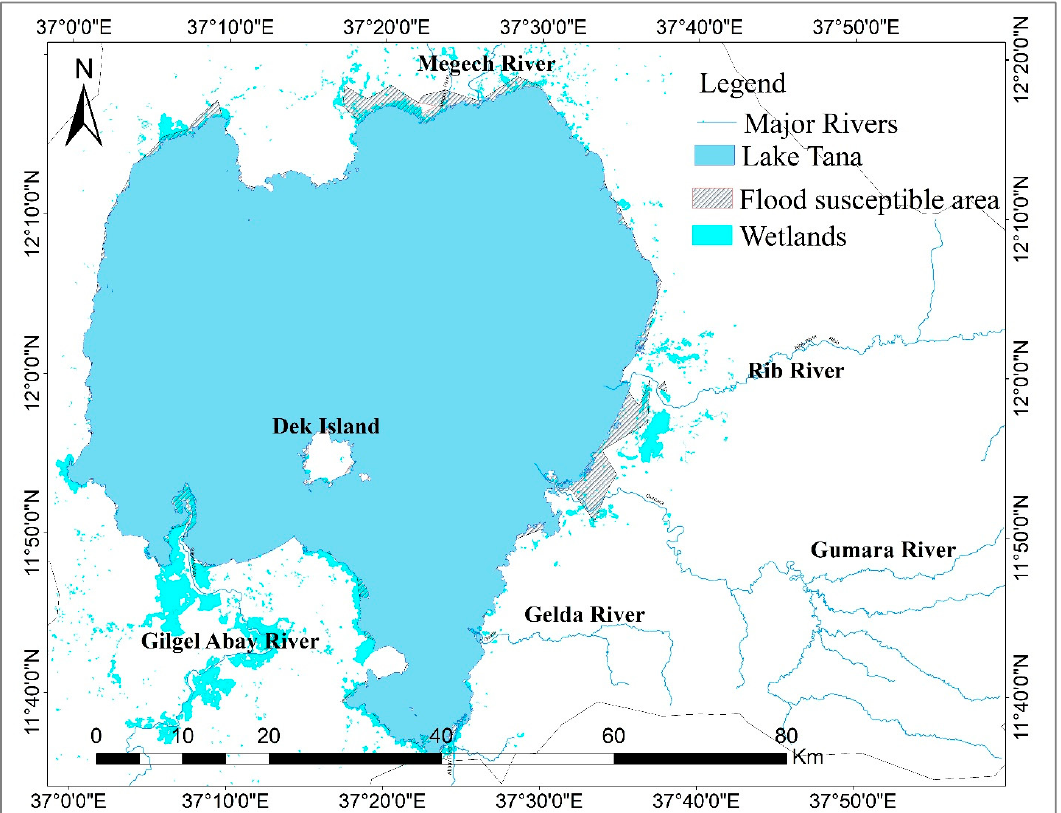
Figure 7. Maximum probable flooding area in the Tana basin at the maximum historical lake level (1788.2 m a.s.l.).